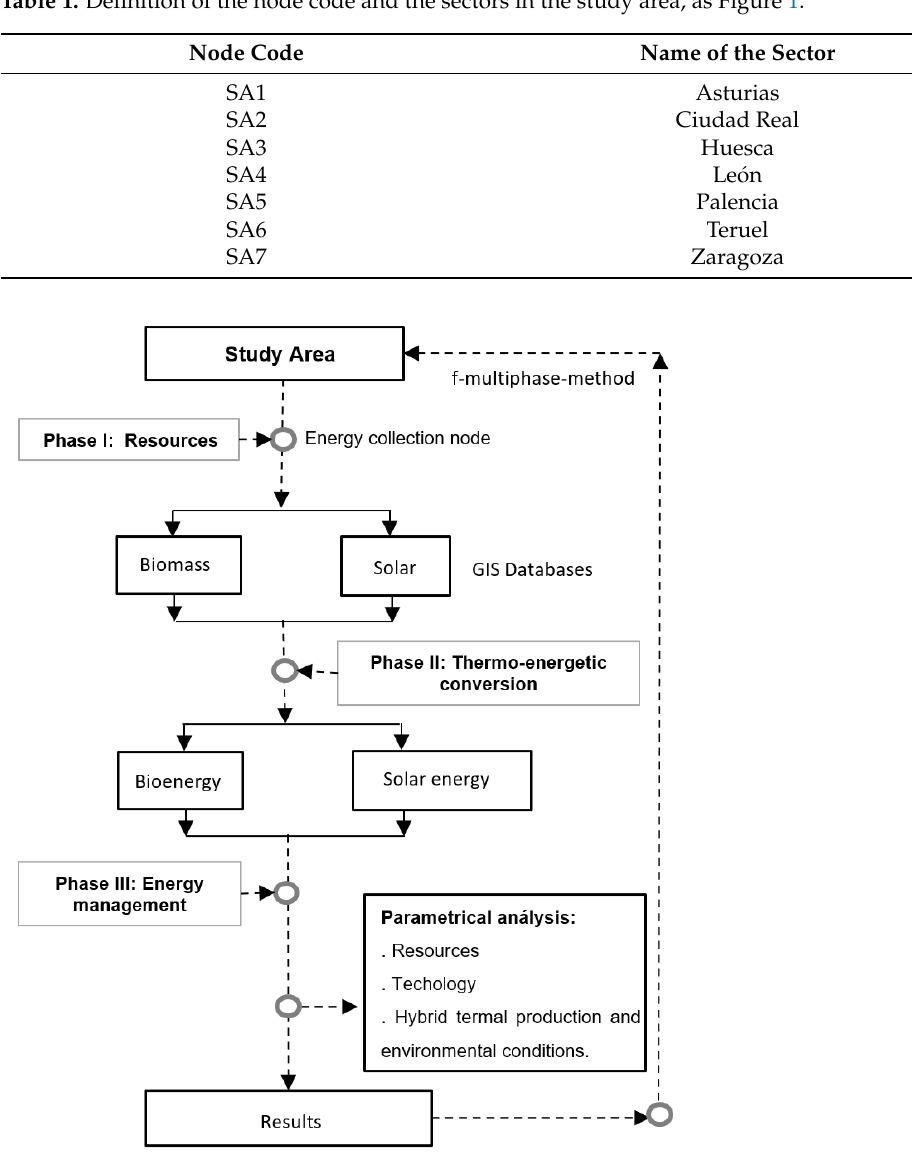
Figure 2. Flowchart of the multiphase mathematical algorithm through mass and energy balance in the study area for biomass and solar energy-based system.